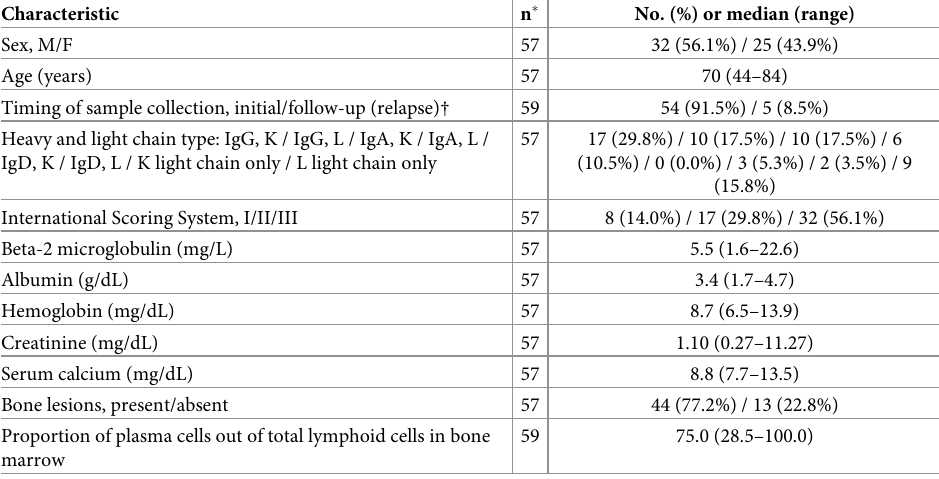
Table 1. Characteristics of 59 bone marrow samples from 57 Korean patients with multiple myeloma. Characteristic